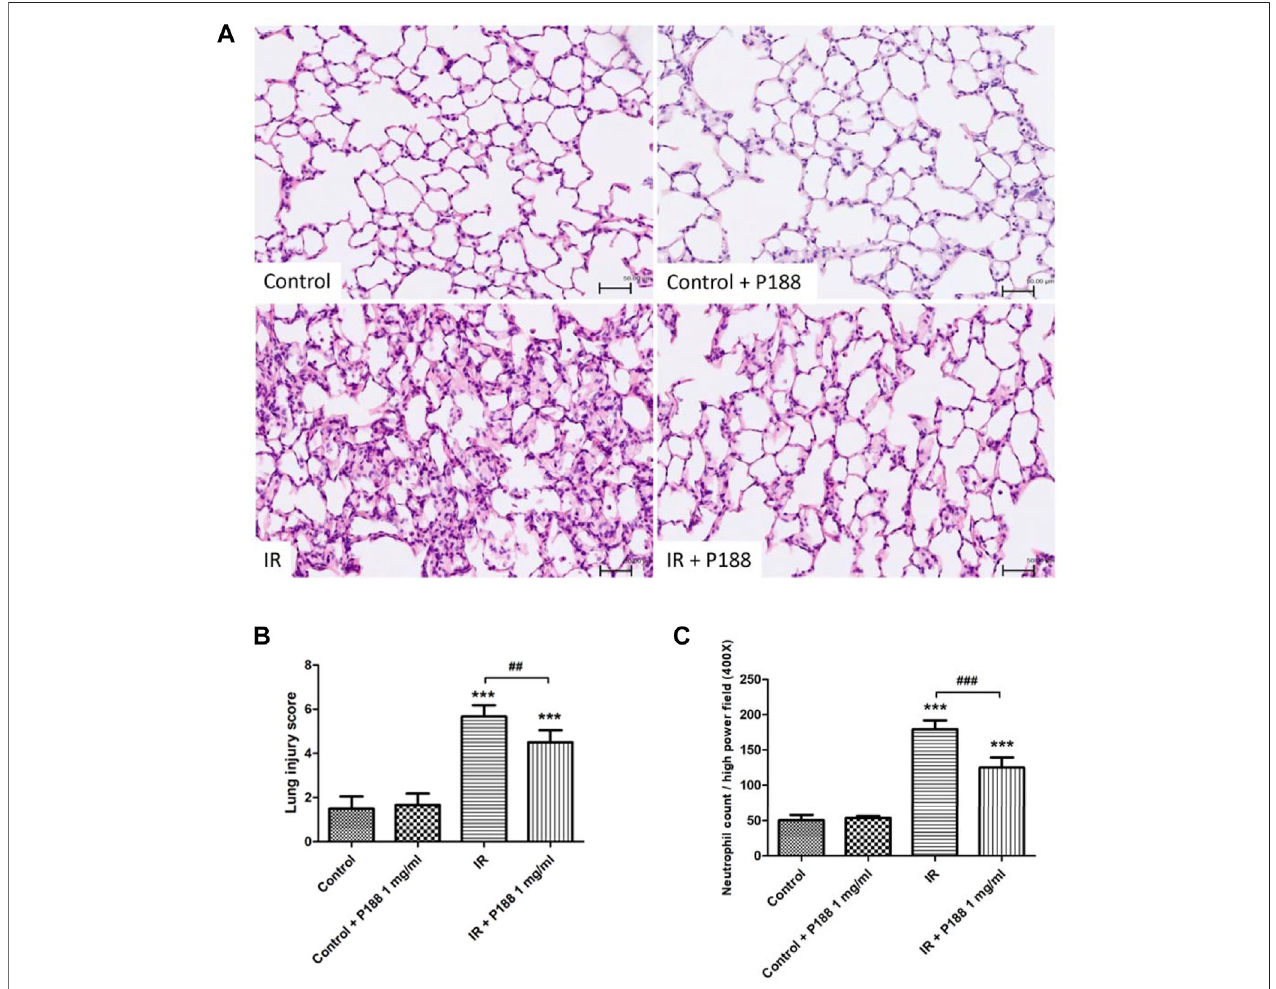
FIGURE4| EffectofP188onhistopathologicalchangesinlungsexposedtoischemia/reperfusion(IR).Hematoxylinandeosinstaining( × 200) (A) ,lunginjuryscores (B) ,andthenumberofneutrophilsperhighpower fi eld( × 400magni fi cation) (C) weredeterminedafter60 minreperfusion.Scalebar (cid:2) 50 µm.Dataaremean ± SD(6rats per group). *** p < 0.001 compared with the control group; ## p < 0.01; ### p < 0.001 compared with the IR group.